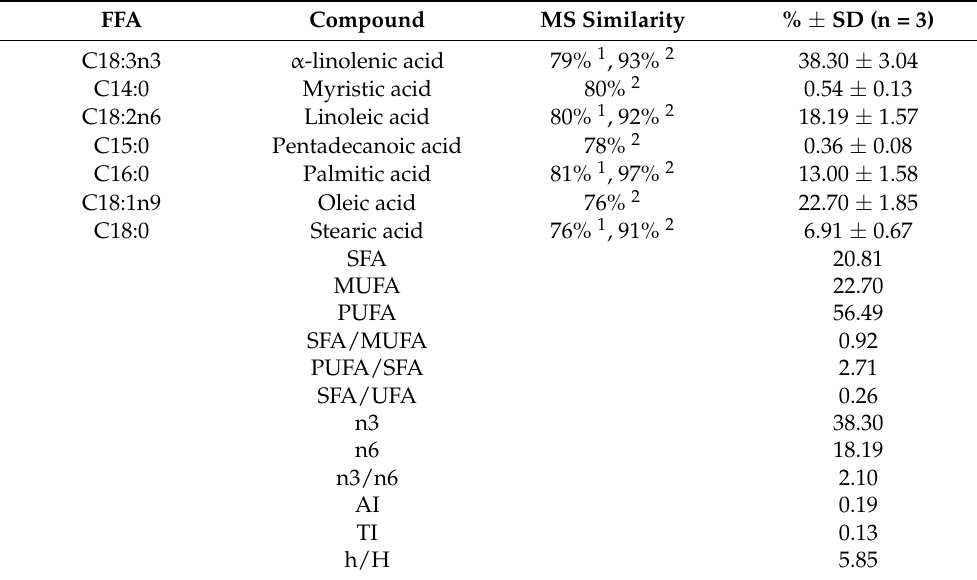
Figure 1. Expansion of NanoLC-EI-MS chromatogram of FFAs in Chia seed oil. Table 3. Mean content of identified FFAs, along with their MS similarity, FFA classes and ratio, and nutritional indices in Chia seed oil.